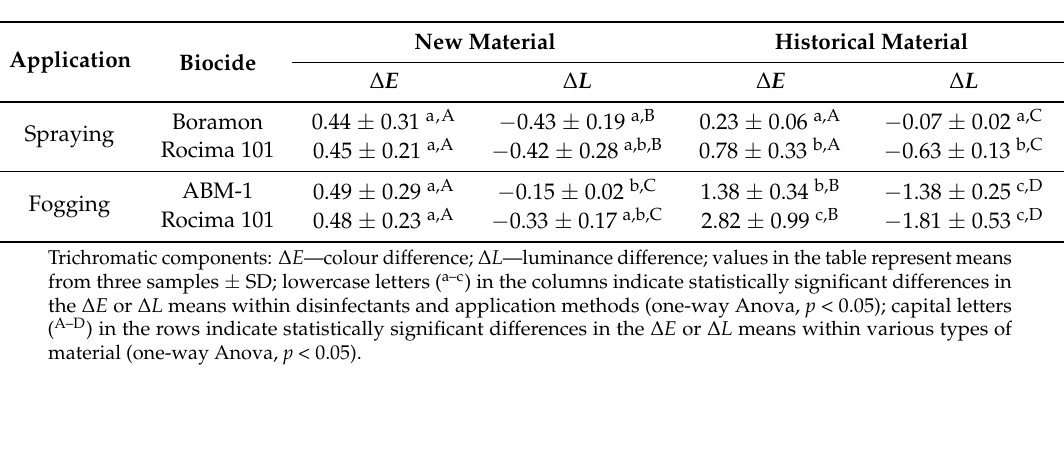
Table 3. The colour and luminance of wood after application of disinfectants.